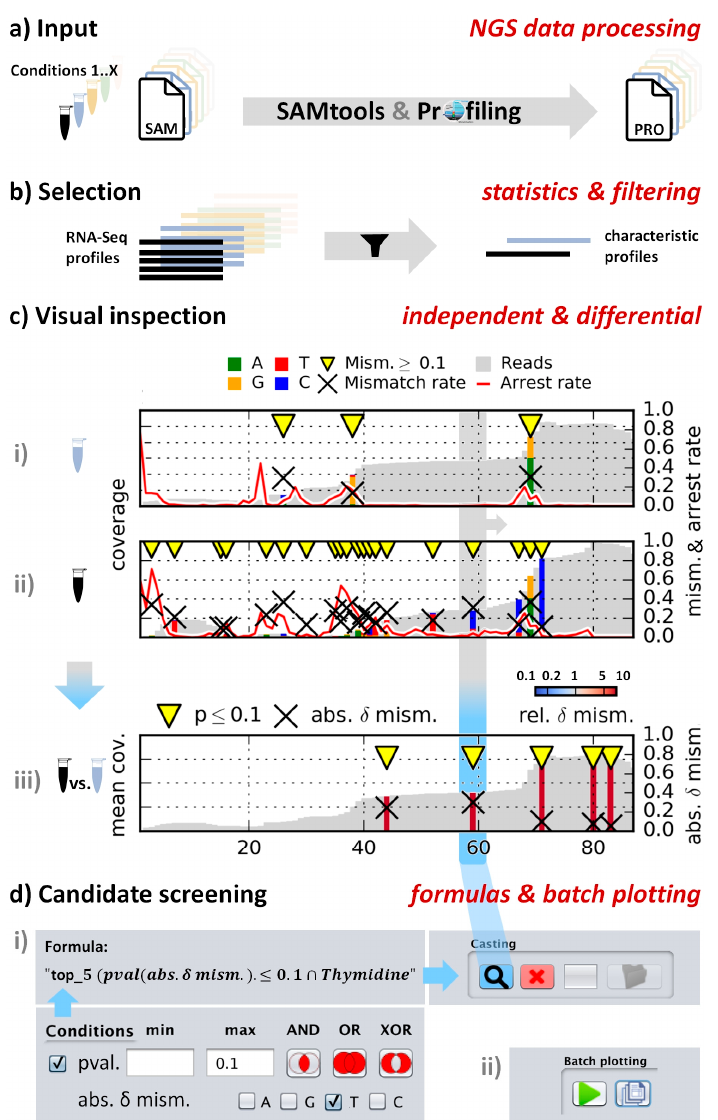
Figure 1. Workflow for a typical CAn session ( a ) Input SAM files are processed to a positional profile; ( b ) Sorting and filtering of data by various statistical criteria. From the depicted result table, users select sequences for visualization; ( c ) Visualization tab. Independent plots and differential comparison for mismatch and/or arrest parameters with marked above-threshold sites (yellow triangle). Display of base sequences is enabled automatically depending on the horizontal plot dimension; ( d ) Candidate casting tab; ( i ) Formula editor: Specification of screening thresholds. Conditions are combined with Boolean operators AND, OR and XOR and can be parenthesized; ( ii ) Control panel for serial plotting of a resulting candidate batch.